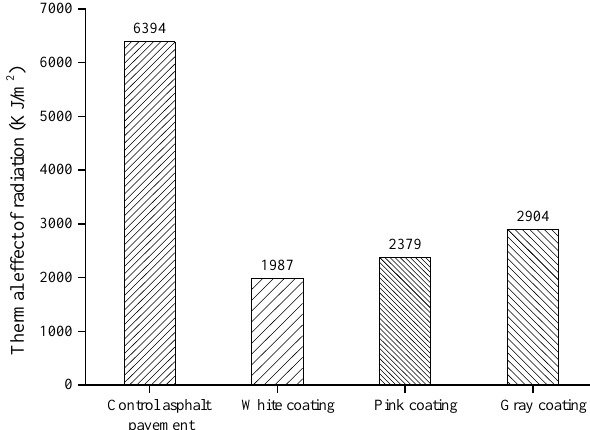
Figure 11. Radiation effect of different asphalt pavement.